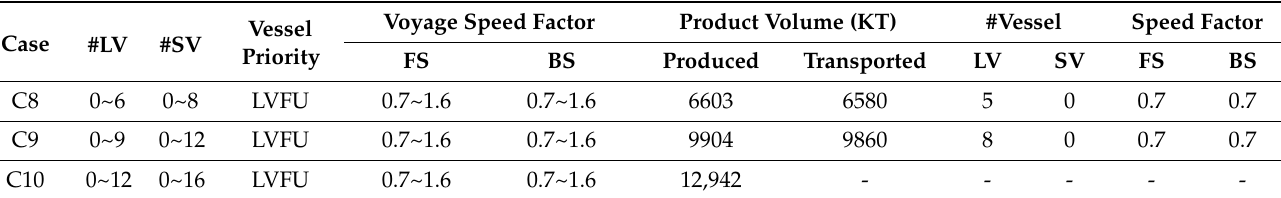
Table 9. Large production volume